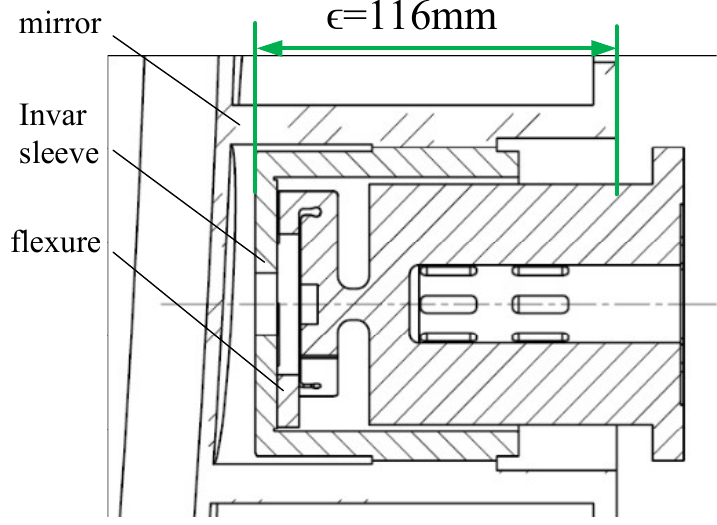
Figure 4. The optimal axial installation position of flexible support. Table 1. The performance and constraints of the mirror assembly under different operating